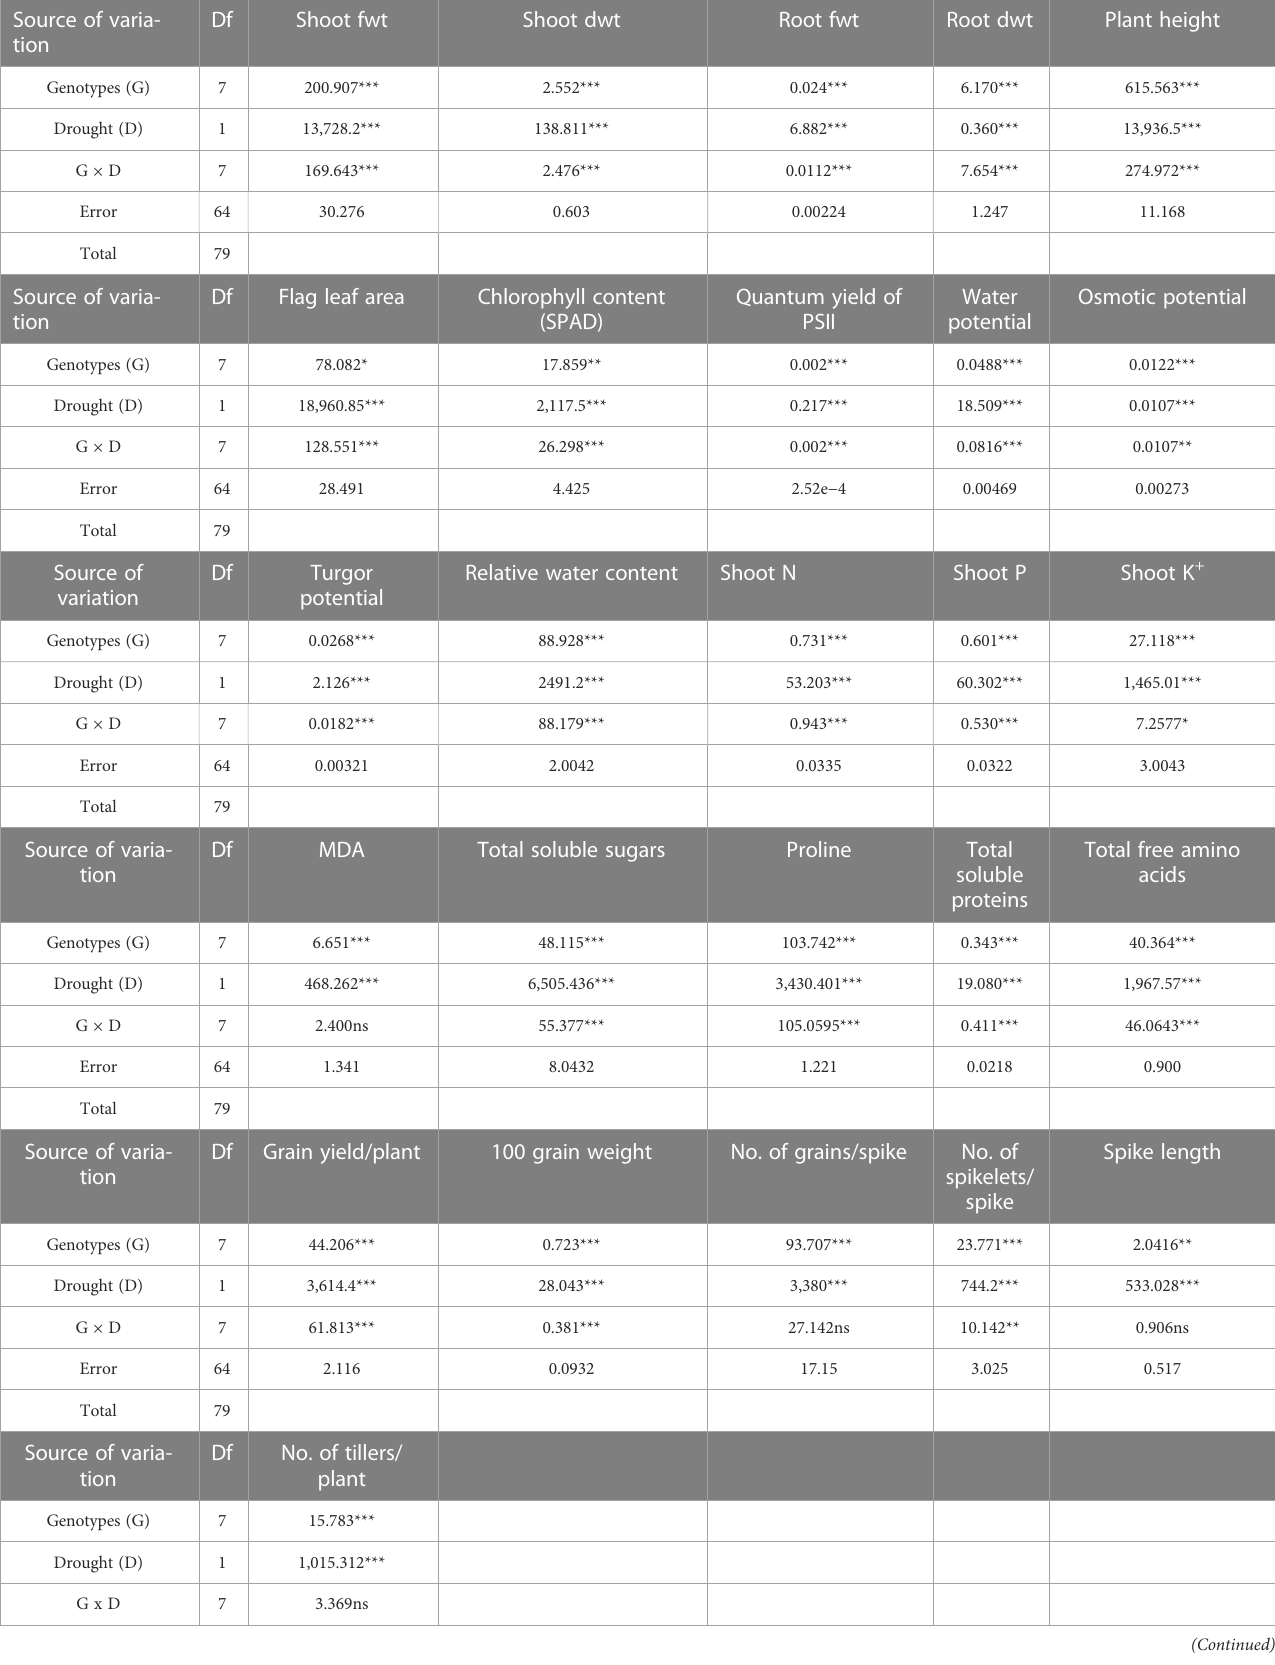
TABLE 1 Mean squares from ANOVA of the data for growth parameters, water relation parameters, mineral nutrients, MDA, organic osmolytes, and yield attributes of eight wheat ( Triticum aestivum L.) cultivars subjected to drought stress at adult growth stage. Source of varia- Df tion Genotypes